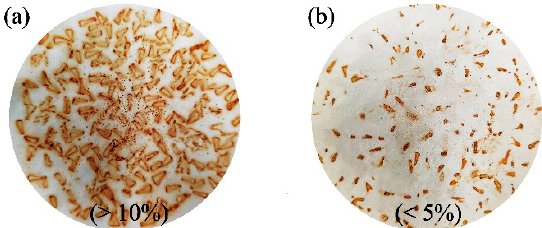
Figure 10. The results of corrosion tests with ( a ) distilled water and ( b ) 2 wt.% JD2000 as anti-rust agent.